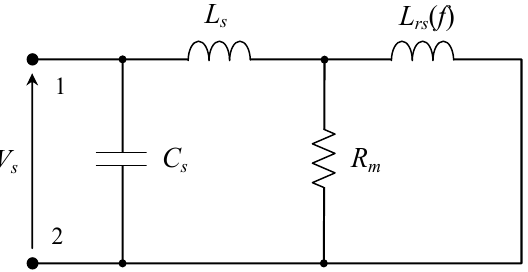
Figure 2. Proposed per-phase equivalent circuit of IM in the switching-frequency range, including stray capacitance and a simplified RL network.